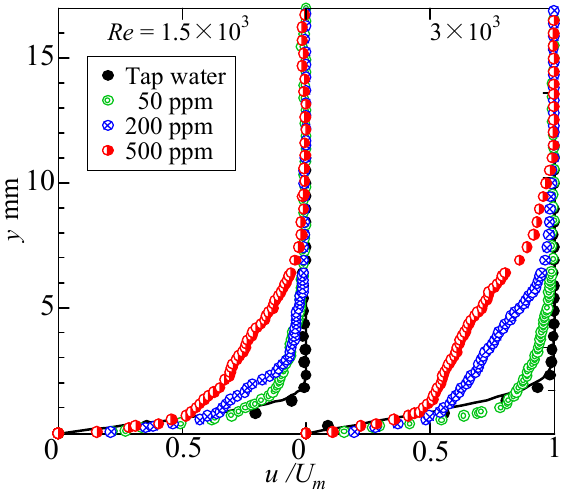
Fig. 4 Effect of increased viscosity on the velocity profile